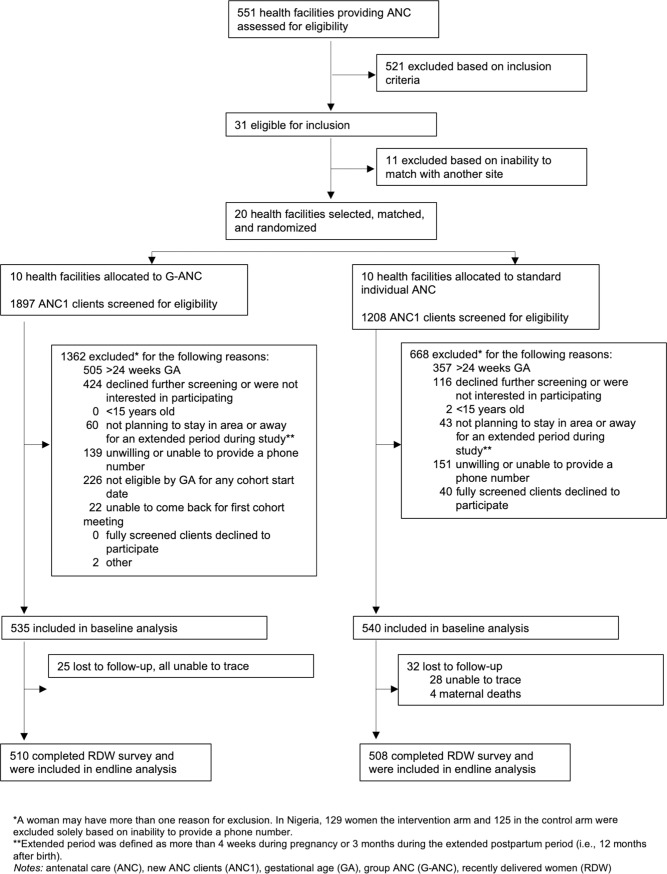
Trial Profile Nigeria.